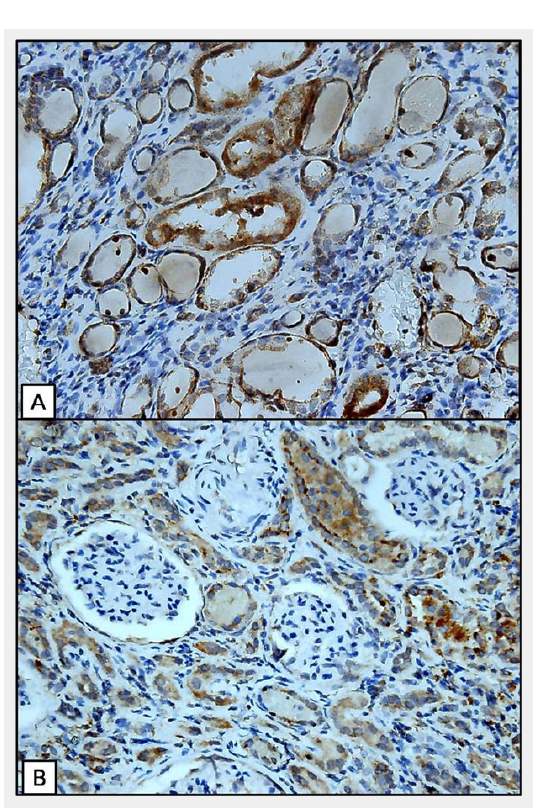
Figure 2 Increased cytoplasmic expression of 8-OHdG in the residual normal tubules in fibrotic renal parenchyma (A) and adjacent to the fibrotic glomeruli (B). (IHC stain,